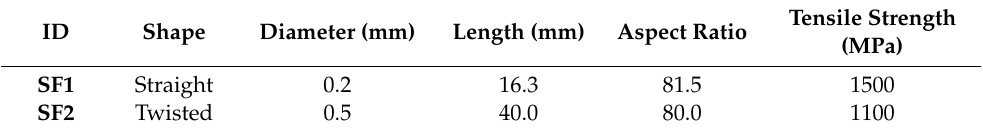
Figure 1. Slags and steel fibers used for experiment: ( a ) steel slags, ( b ) steel fibers. Table 4. Physical parameters of fibers used.